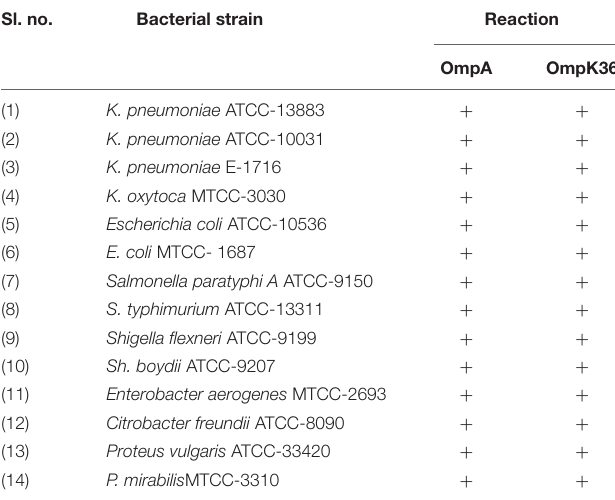
TABLE 2 | List of bacterial strains tested for reactivity with mouse anti-rAK36 sera. Sl.